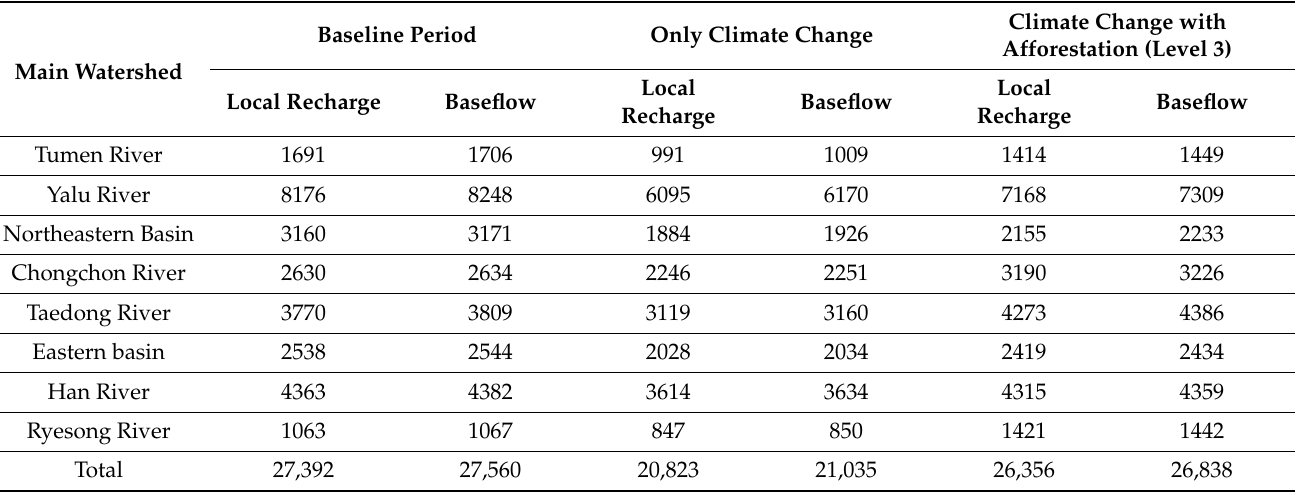
Table 3. Local recharge and baseflow statistics of baseline period and future projection at the main watershed level (million m 3 y − 1